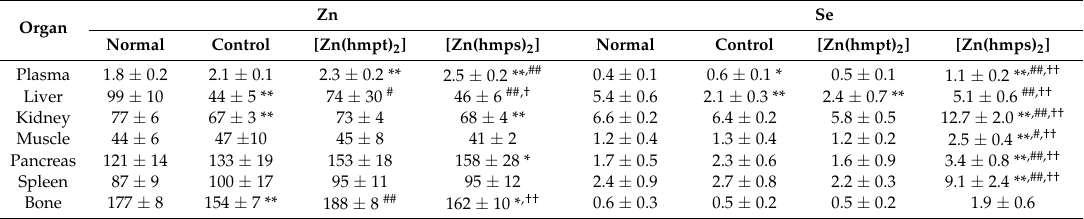
Table 3. Zn and Se concentrations in dry tissues ( µ g/g) and plasma ( µ g/mL) in normal, control (PEG-400 administered), [Zn(hmpt) 2 ]-treated, and [Zn(hmps) 2 ]-treated